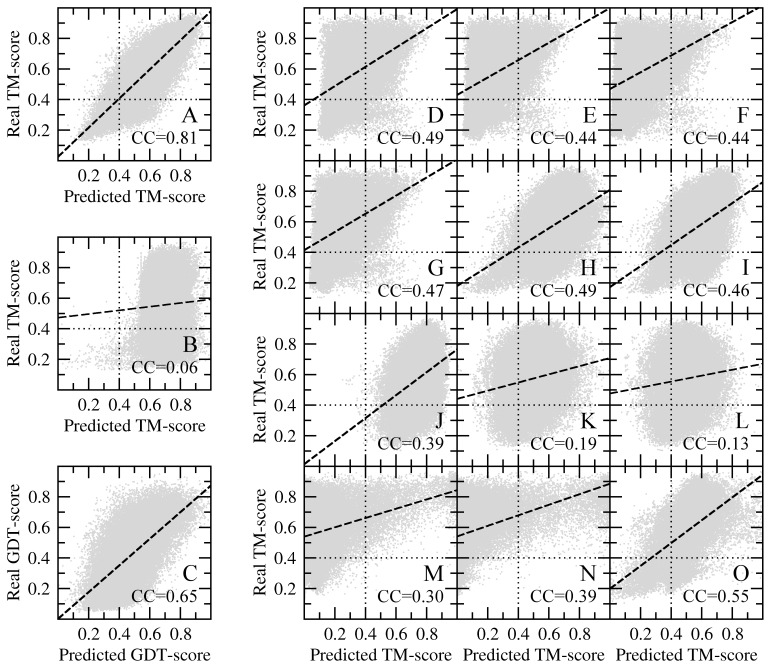
Quality assessment by eRank/TASSER-Lite.Three plots on the left show the correlation between the real TM-score of models built by eThread/TASSER-Lite and the TM-score is estimated by (A) eRank, (B) SELECTpro and (C) APOLLO. For APOLLO, GDT-score is used instead of TM-score. Individual scoring components of eRank are shown on the right: (D) TM-score, (E) eThread, (F) Alignment, (G) Coverage, (H) DOPE, (I) dFire, (J) PSIPRED, (K) SecStr, (L) Burial, (M) TASSER-Litefract, (N) TASSER-Litedens, and (O) TASSER-Liteene. In A, B and D–O, dotted lines delineate the TM-score statistical significance threshold.